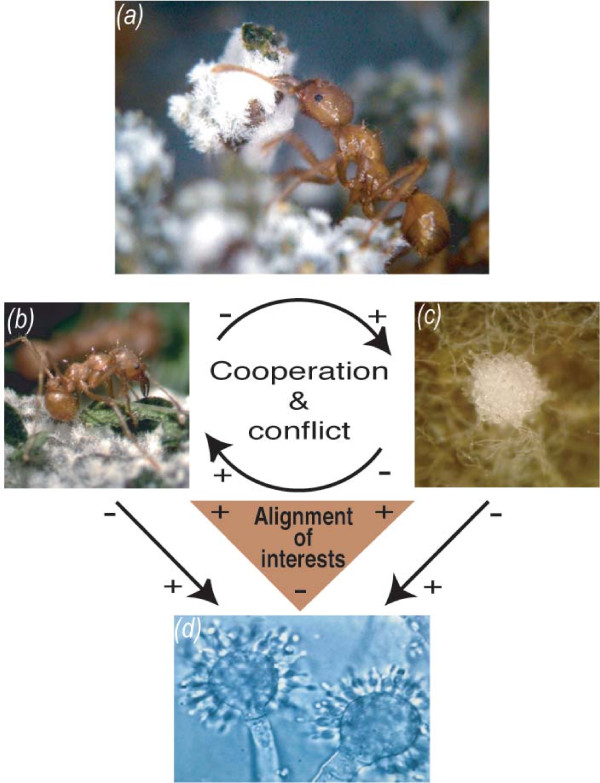
Cooperation and conflict within the fungus-growing ant microbe symbiosis. A) Fungus-growing ants forage for substrate to nourish their cultivated fungus, which they also groom to help remove garden parasites. B) In return, the fungus serves as the primary food source for the ants; with some species producing nutrient-rich hyphal swellings (gongylidia) that the ants preferentially feed on. Cooperation and conflict is inherent to the ant-fungus mutualism (black arrows, head points toward recipient of benefit), with each symbiont receiving a benefit (+), at a cost to the other (-). Natural selection favors symbionts that increase their own fitness selfishly by exploiting their partner, receiving a benefit (+) without paying the cost (-) associated with providing a benefit in return. C) The mutualism is parasitized by specialized fungi in the genus Escovopsis, which acquire nutrients from the fungus garden at a direct and indirect cost to the cultivated fungus and ants, respectively. Cooperation is enforced, and cheaters minimized, because the selfish interests of both ants and cultivated fungus are aligned (orange triangle) against the parasite Escovopsis.